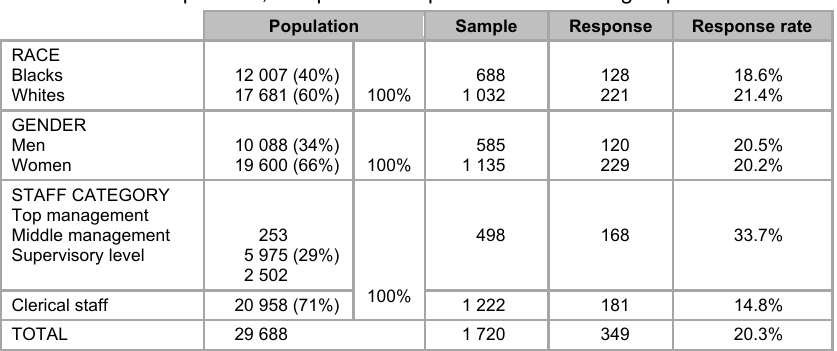
Population, sample and response rate of each group Population Sample Response Response